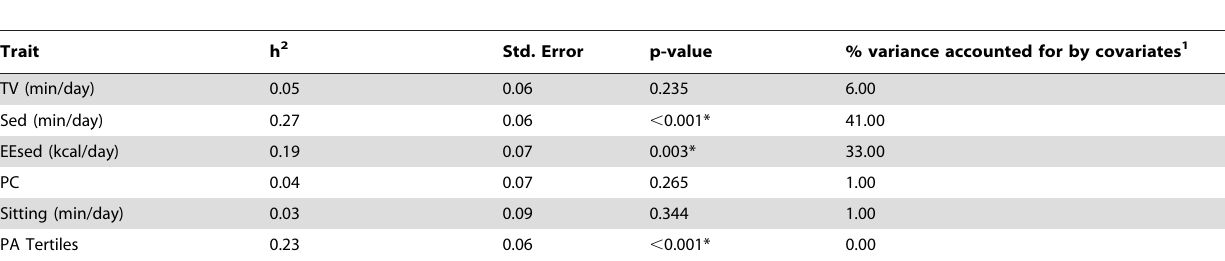
Table 2. Heritability estimates (h 2 ) and % of variance accounted for by covariates of different sedentary phenotypes in the Portuguese Healthy Families